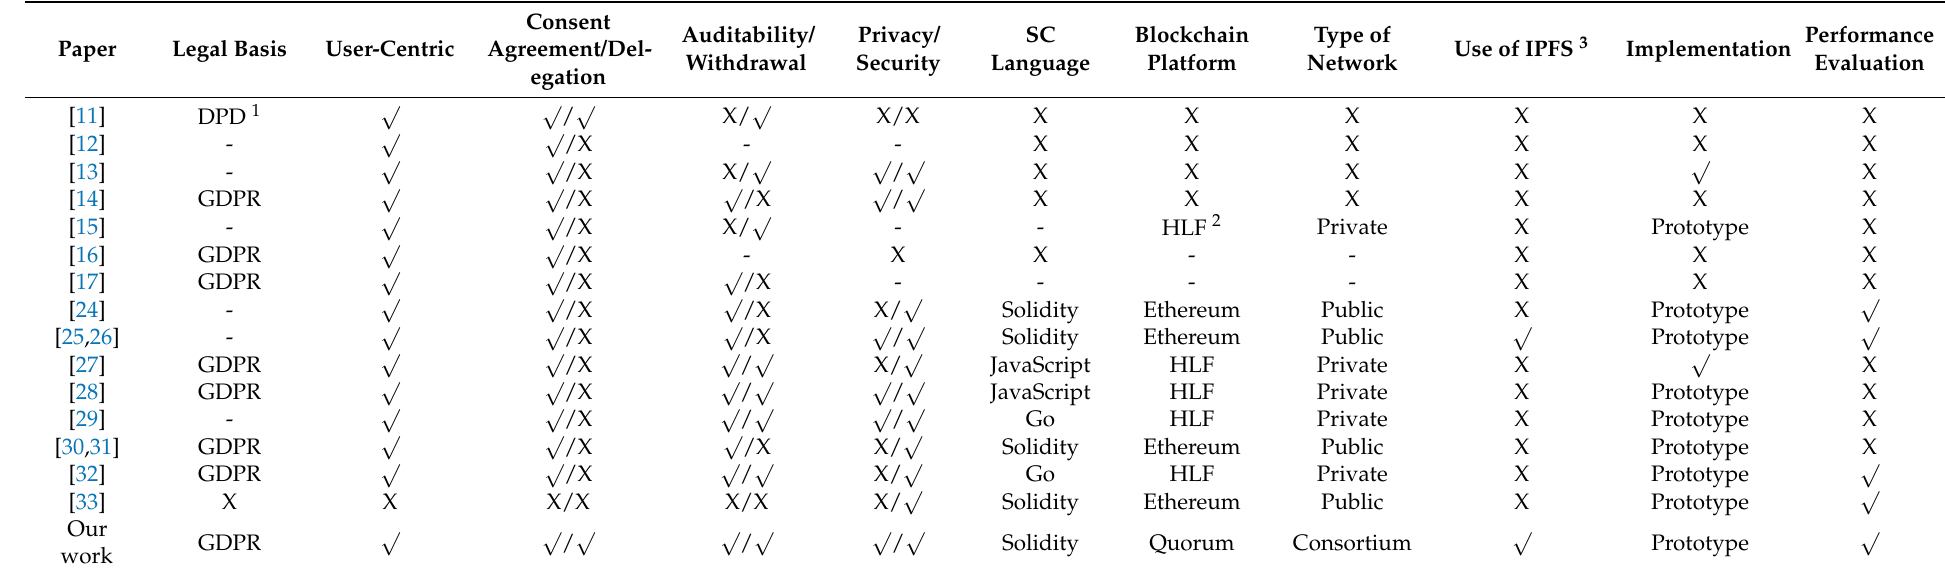
Table 2. Comparison of the proposed system with related